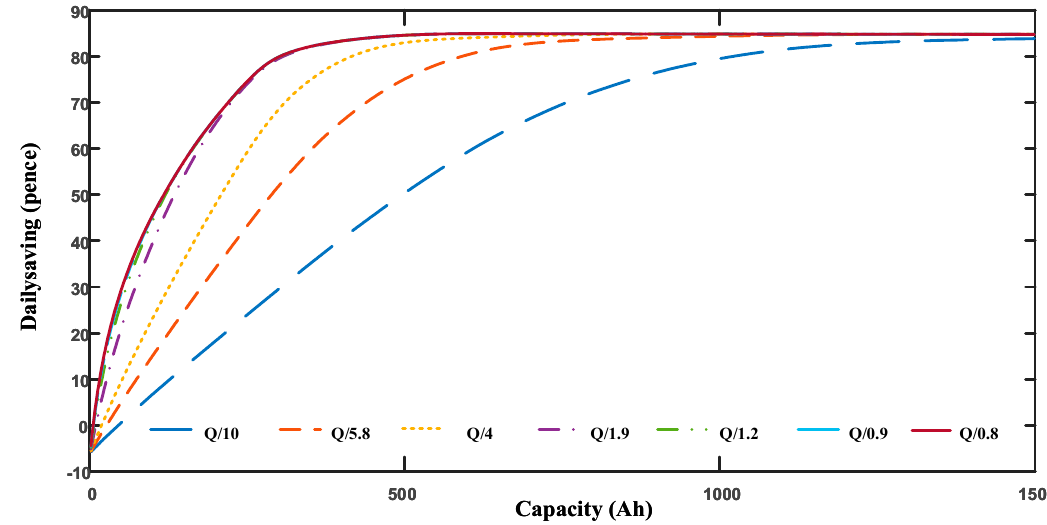
Figure 6. Daily energy cost saving vs. battery capacity at different discharge currents (medium discharge).